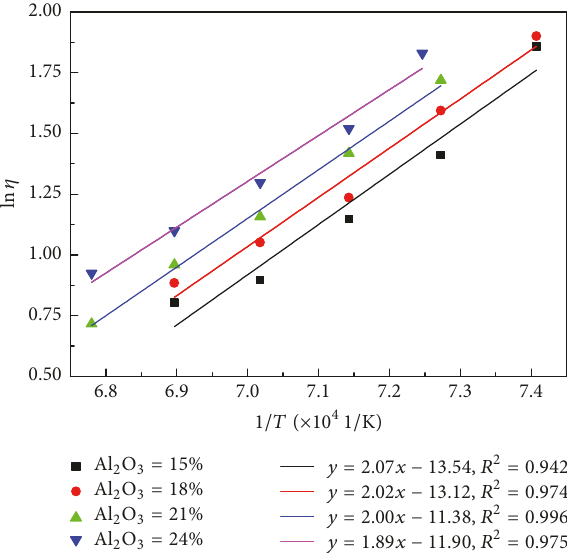
Figure 5: Effect of Al 2 O 3 content on apparent activation energy.